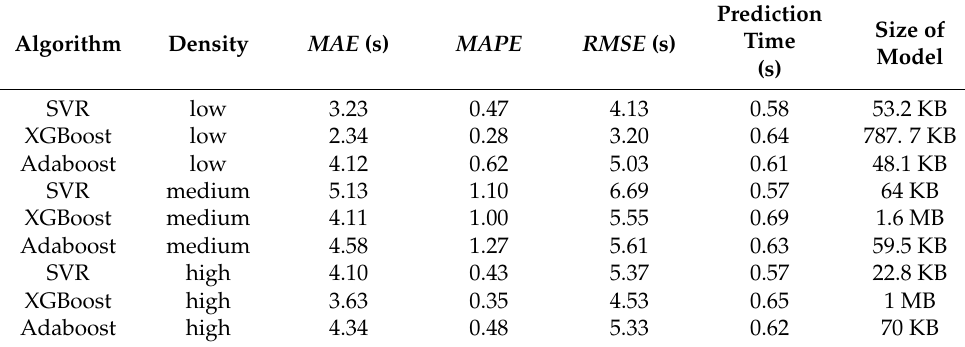
Table 6. Summary of the new hypothesis’s experimental findings.